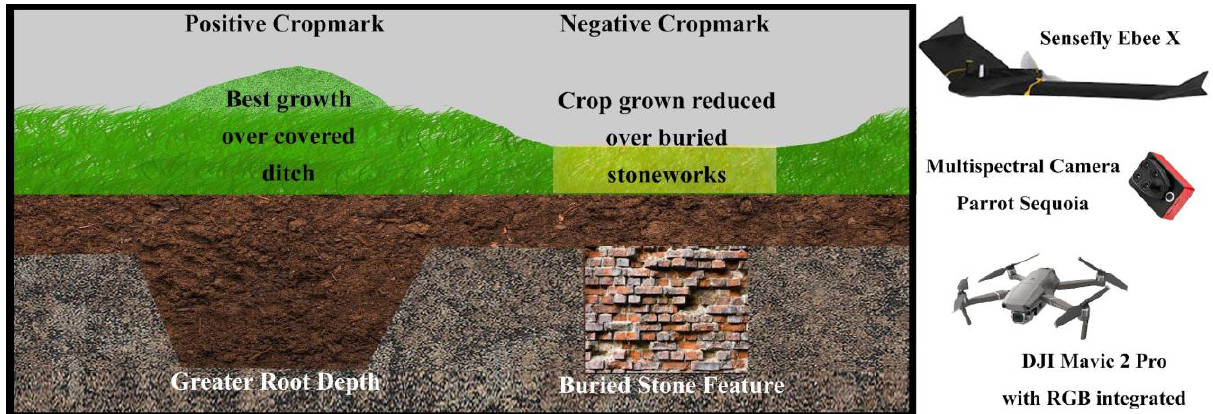
Figure 4. Positive and negative cropmarks with instruments for photogrammetric surveys from